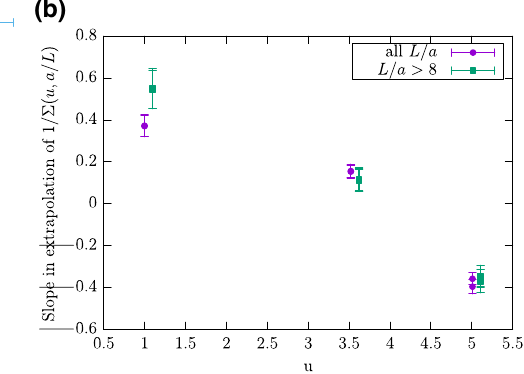
Fig. 13 a Continuum extrapolations of the lattice SSF of the magnetic GF coupling at 3 target values of the coupling, Eq. (A.1). (Data from Table 6.) We consider the lattice resolutions: L / a = 8 , 10 , 12 , 16 , 24, and perform linear fits of the data in ( a / L ) 2 , with and without the